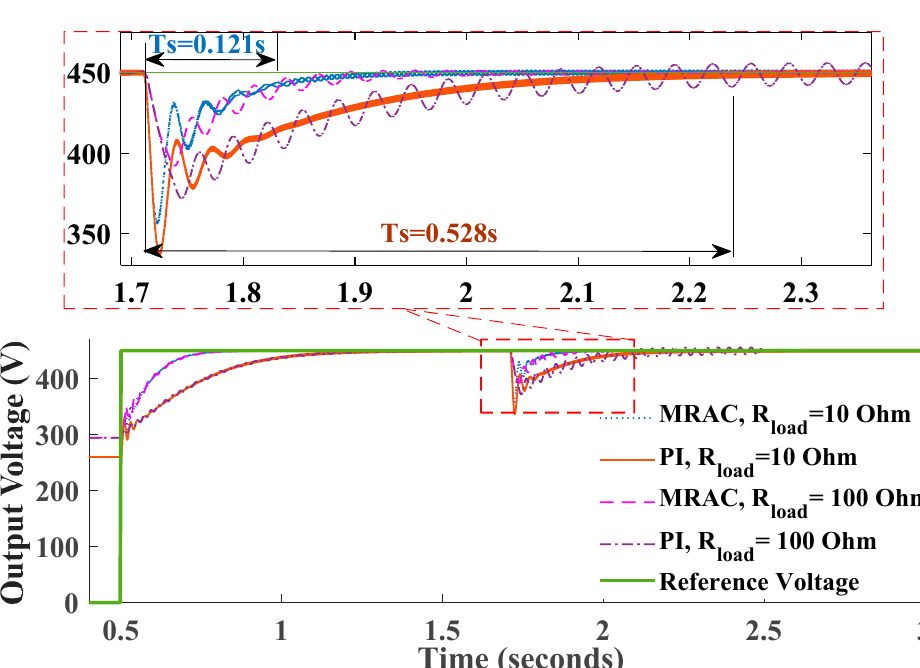
Figure 8. Output voltage of the boost converter for fall in input voltage with MRAC and PI controller.